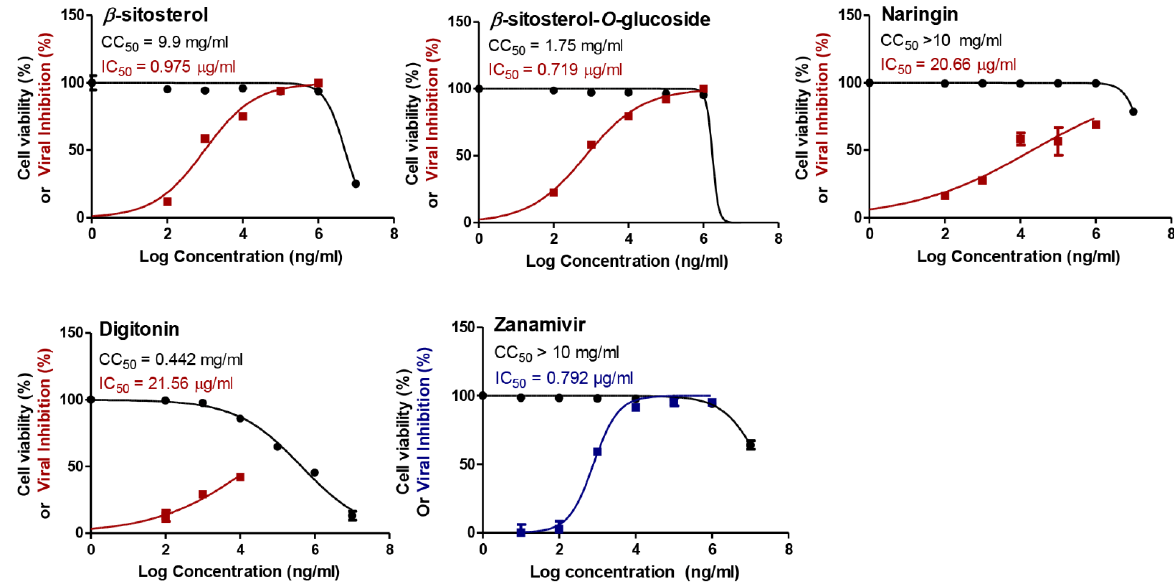
Figure 1. The cytotoxicity as expressed in CC 50 (half‑maximal cytotoxic concentration) and the anti- viral efficacy against A/H1N1 as expressed in IC 50 (half-maximal inhibitory concentration) for the studied phytochemicals. GraphPad Prism 5.01 software was used to analyze the nonlinear regres- sion while the CC 50 and IC 50 were determined by plotting log inhibitor against normalized response (variable slope).